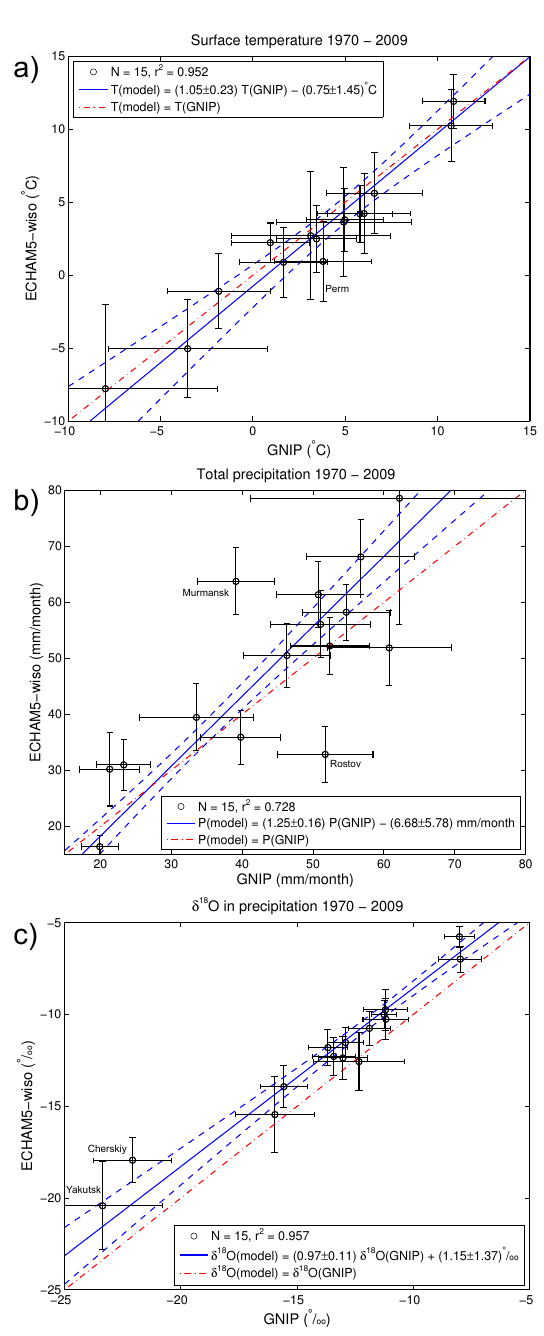
Figure 3. Comparison of mean values of (a) surface tempera- ture, (b) precipitation amount, and (c) δ 18 O in precipitation for a selection of 15 GNIP stations located in Russia and the related ECHAM5-wiso model results (see text for details on station selec- tion and mean value calculation at each station). Length of the error bars is ± 2 standard errors of the estimated means. Straight lines are obtained from a weighted total least-squares algorithm accounting for uncertainties in both observations and model results (Krystek and Anton, 2007), dashed lines are 95% confidence intervals for the